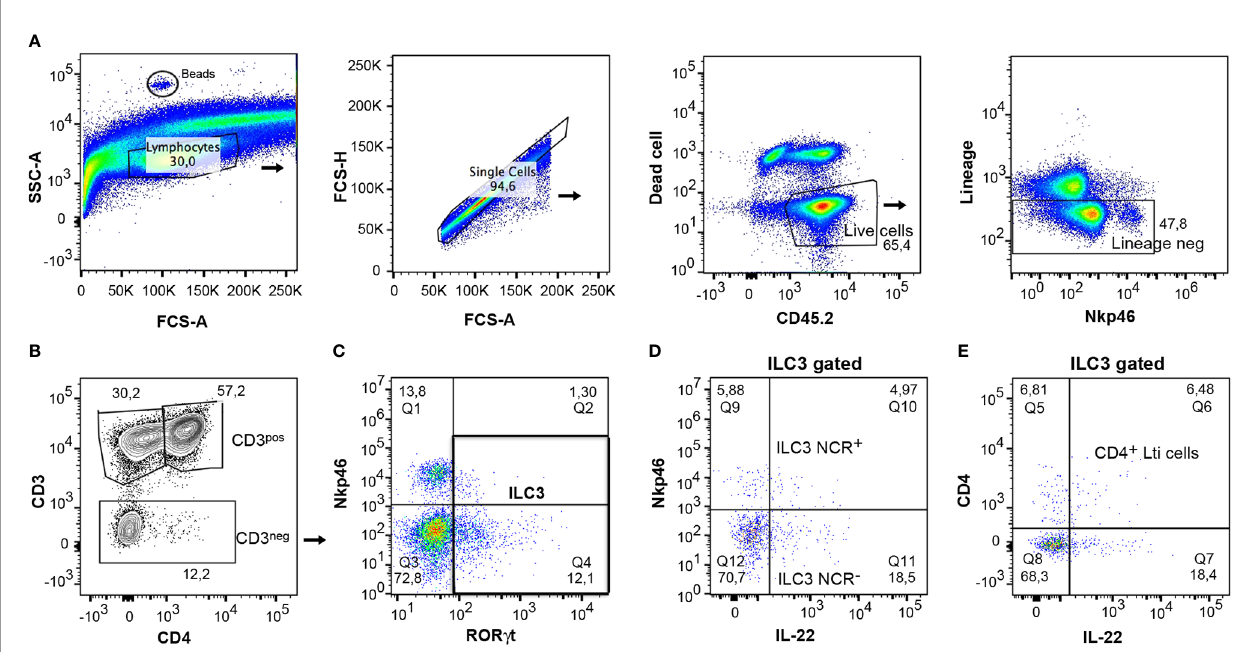
FIGURE 7 | Gating strategy for analysis of mouse cytokine expressing ILC3s from colon. (A) CD45 + live cells and negative lineage were gated to analyze the different lymphocyte populations. Counting beads were included to analyze the absolute numbers of the different cell populations. (B) The expression of CD3 and CD4 served to differentiate the CD3 + CD4 + lymphocytes, the CD3 + CD4 - lymphocytes (CD8 and g d cells), and the CD3 - cells, which include the innate lymphoid cells. (C) The CD3 - cells were gated and the expression of ROR g t and Nkp46 was analyzed to discern between the ILC3s populations. (D) The expression of IL-22 was analyzed in both populations, ILC3 NCR + and ILC3 NCR - . (E) IL-22-producing cells were quanti fi ed in CD4 + Lti